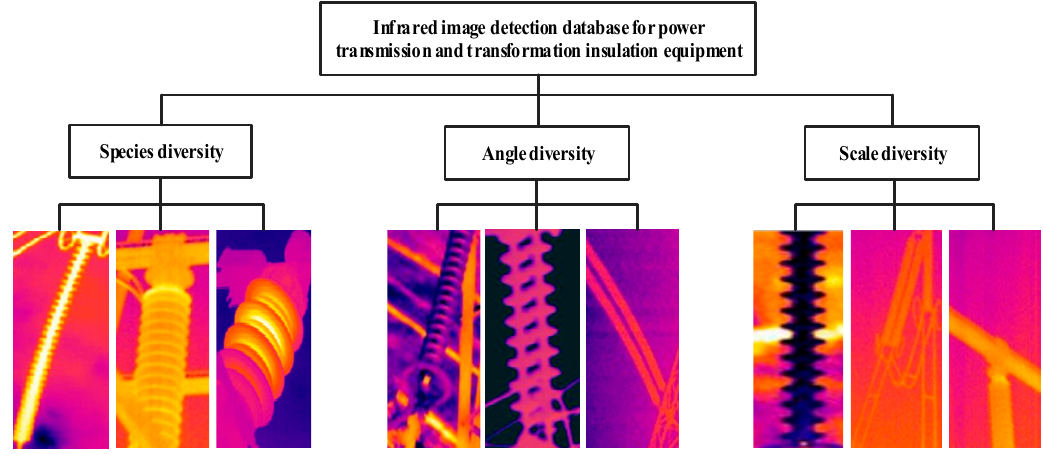
Figure 4. Diversity display of infrared image detection database for power transmission and transformation insulation equipment.